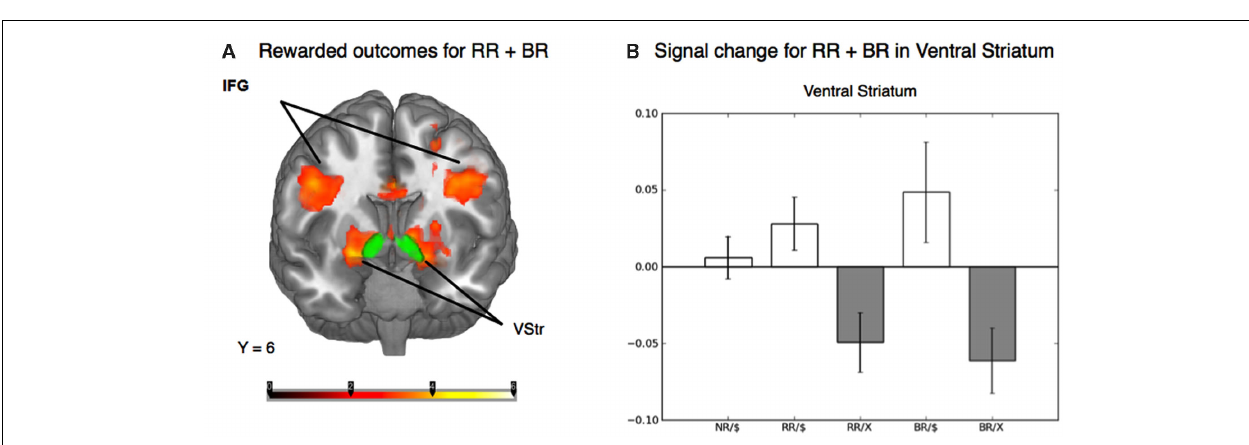
FIGURE 4 | (A) Whole-brain analysis of the outcome phase of the task for rewarded greater than unrewarded trials in the reward risk (RR) and behavioral risk (BR) conditions. Rewarded trials elicited greater activation in regions typically implicated in reward processing, such as the ventral striatum (Vstr), which includes the nucleus accumbens and caudate, and putamen, and additionally activated the global pallidus and inferior frontal gyrus (IFG).The